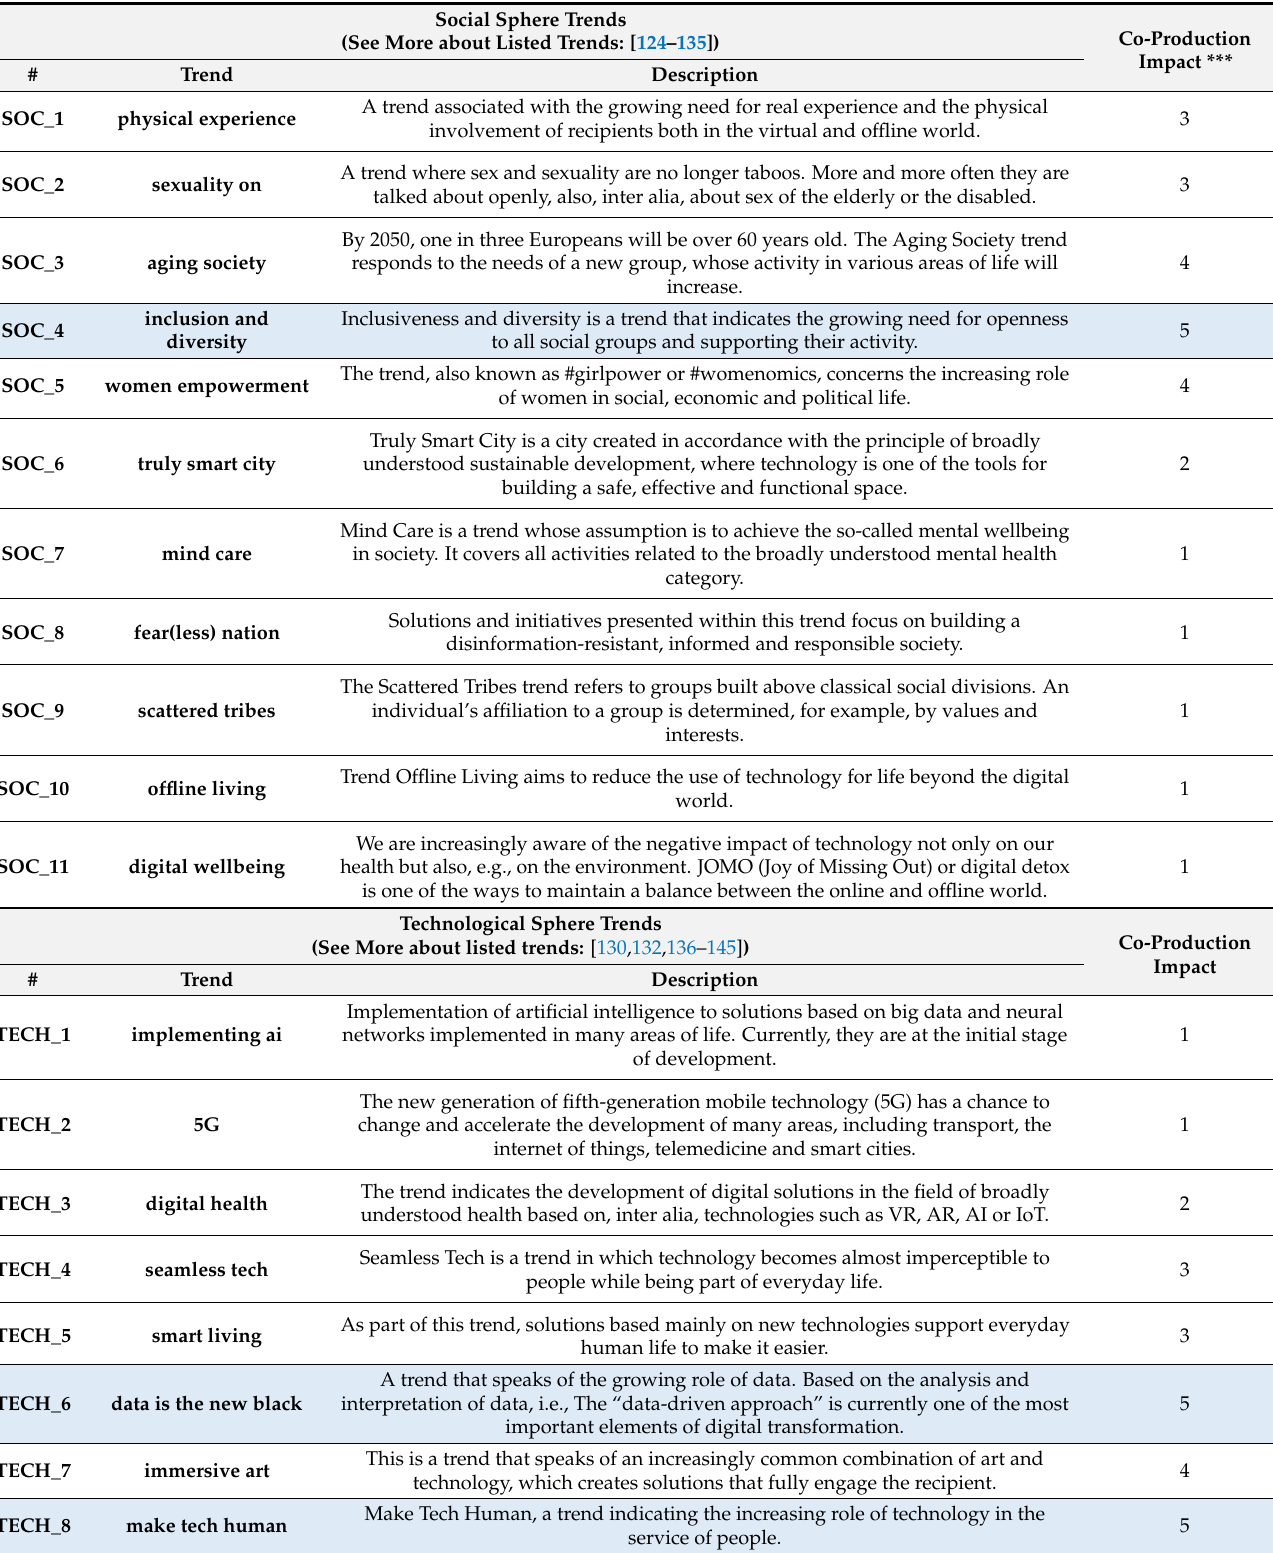
Table 1. Specific Industry 4.0 trends and their estimated impact on the development of business models based on co-production and